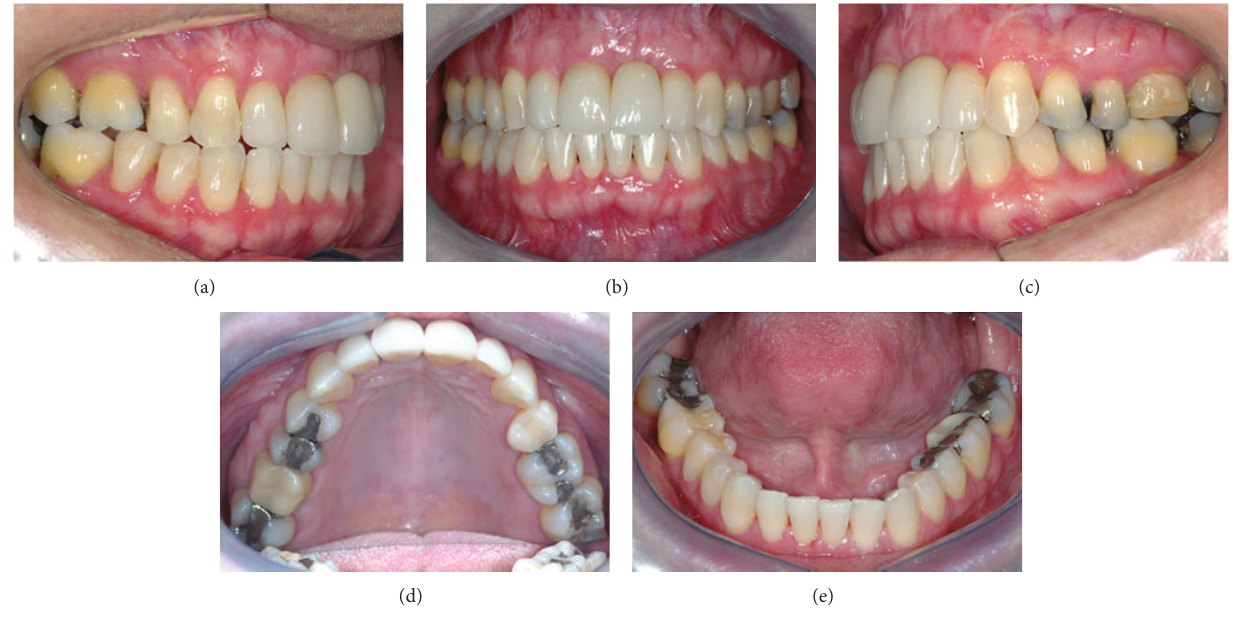
Figure 13: 6-year follow-up intraoral photographs.